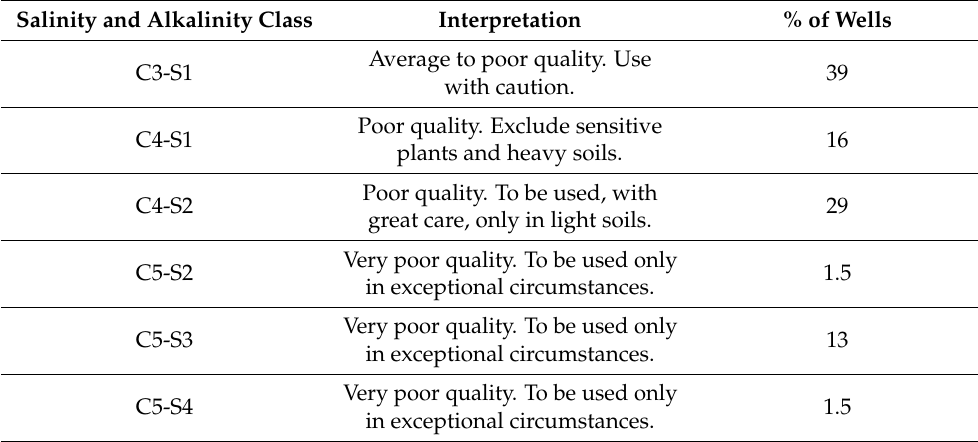
Table 1. Classification of irrigation water according to salinity (Richards, 1954).